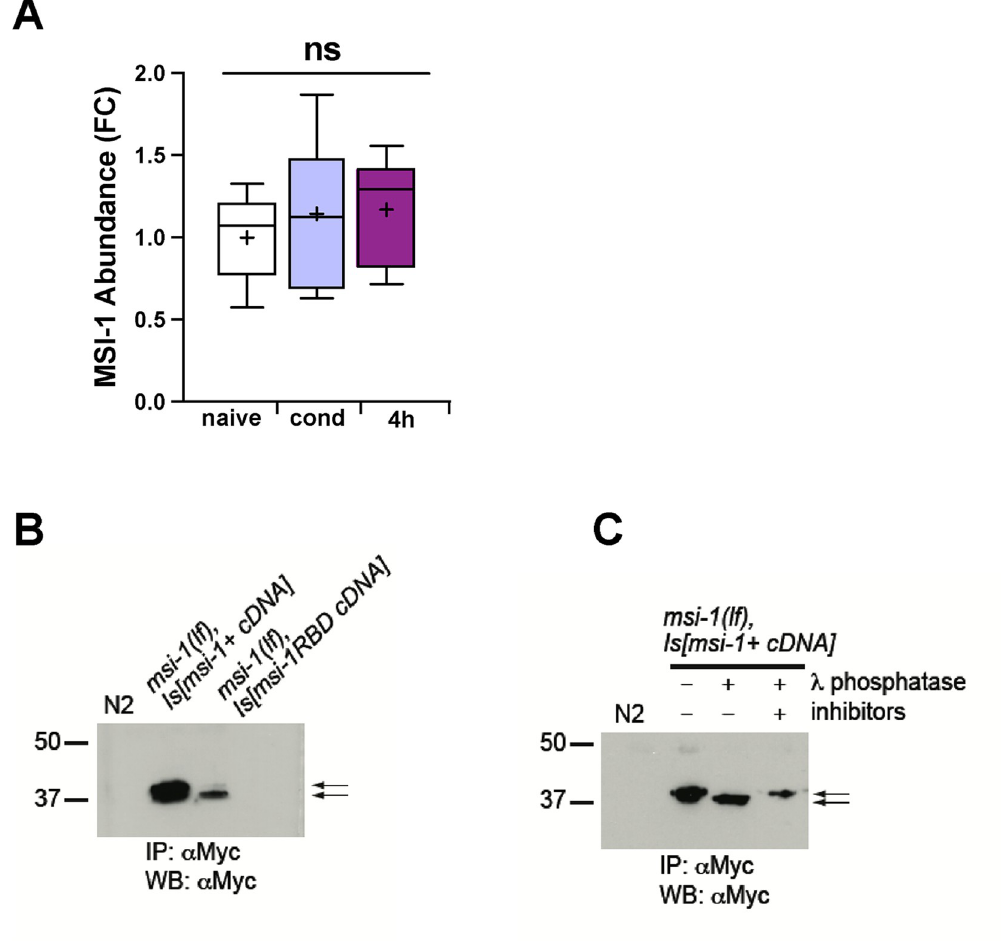
Fig 1. elegans MSI-1 is a phosphoprotein whose abundance remains constant upon learning and memory. C . (A)Worms were collected before (naive), right after (cond) or 4 hours after (4h) conditioning; MSI-1 was immunoprecipitated and analyzed with MS. Abundance of MSI-1 was estimated from calculating the summed abundance of all detected MSI-1 peptides resulting from tryptic digestion. Squares represent values as fold changes compared to the mean of NAI¨VE. Bars correspond to mean +/- SD. Significance was tested with 1-way ANOVA. ns: not significant. Graph summarizes results from 3 independent biological replicates, each biological replicate consists of 3 technical repetitions. (B-C) Western blot of total C . elegans protein extracted from synchronized adult population, followed by anti-Myc immunoprecipitation, probed with anti- Myc antibody. (B) Detection of Myc-tagged wild-type and RNA-binding mutant MSI-1 protein. (C) Immunoprecipitated Myc-tagged wild-type MSI-1, followed by treatments with or without Lambda phosphatase in absence or presence of phosphatase inhibitor cocktail. Arrows show the two MSI-1 bands with different electrophoretic mobility corresponding to phosphorylated MSI-1 (upper band) and non-phosphorylated MSI-1 (lower band).